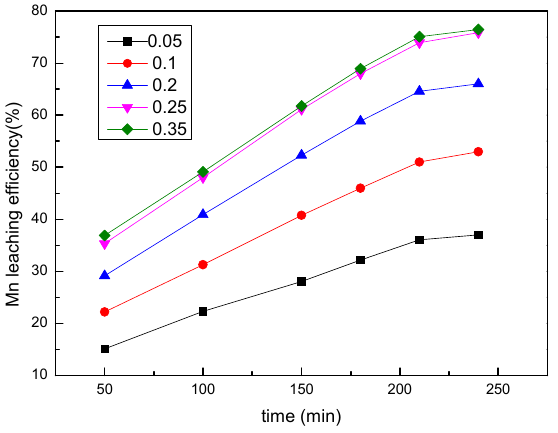
Figure 4. The effect of sawdust/ore mass ratio on the manganese leaching efficiency.